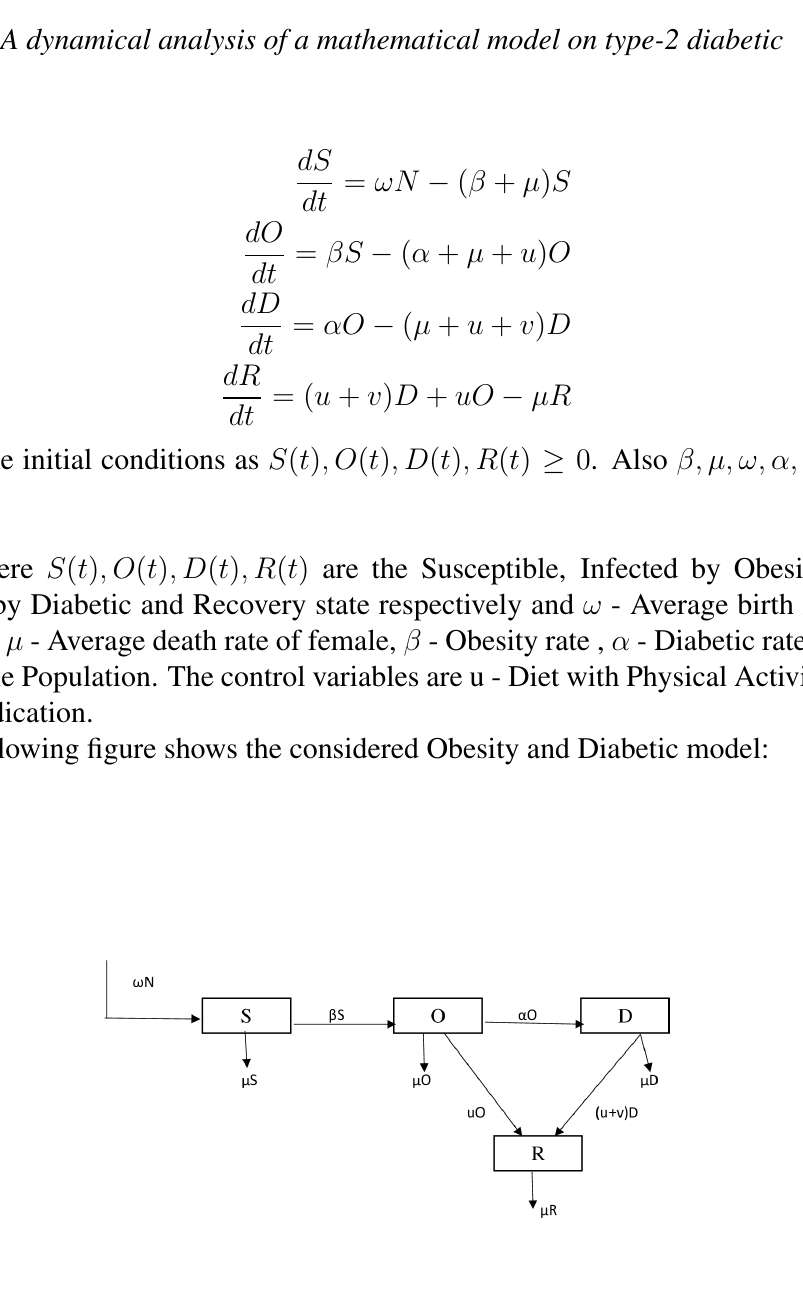
Figure 1: Obesity and Diabetic